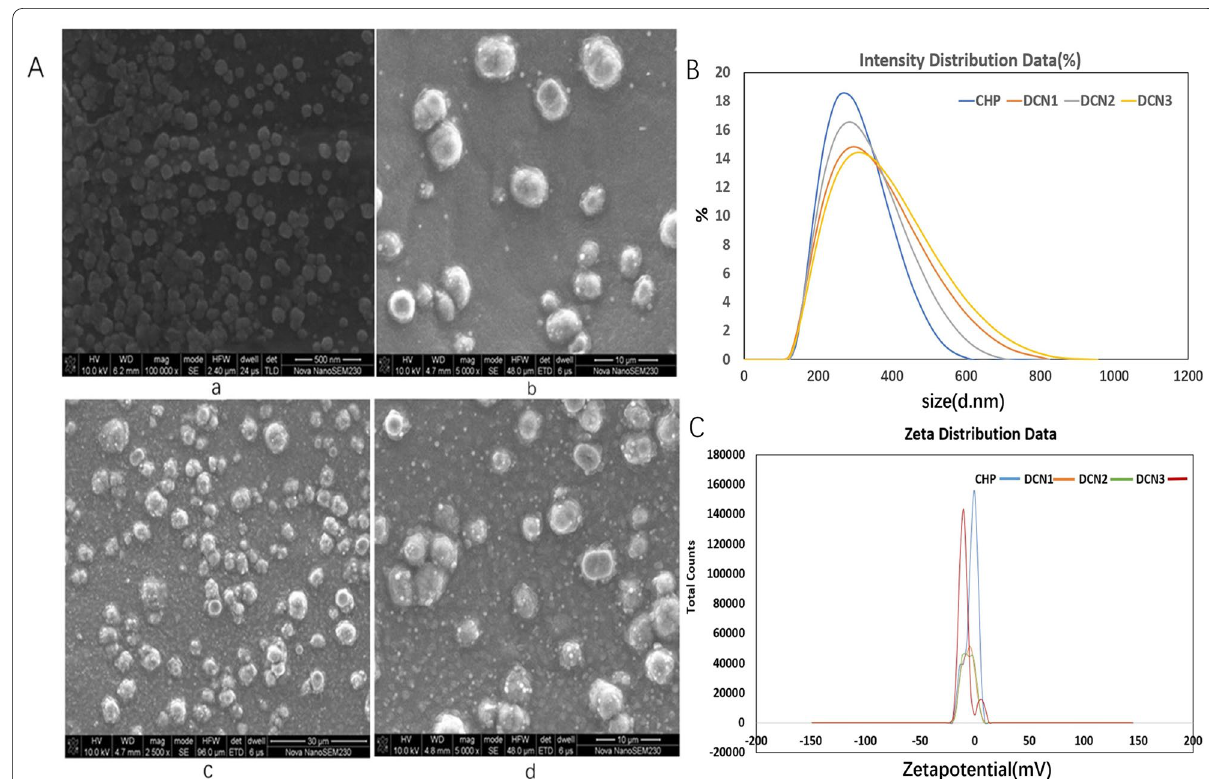
Fig. 1 Scanning electron microscopy images ( a , a-CHP, b-DCN1, c-DCN2, d-DCN3), size distribution ( b a-CHP, b-DCN1, c-DCN2, d-DCN3) and zeta potential ( c a-CHP, b-DCN1, c-DCN2, d-DCN3) of